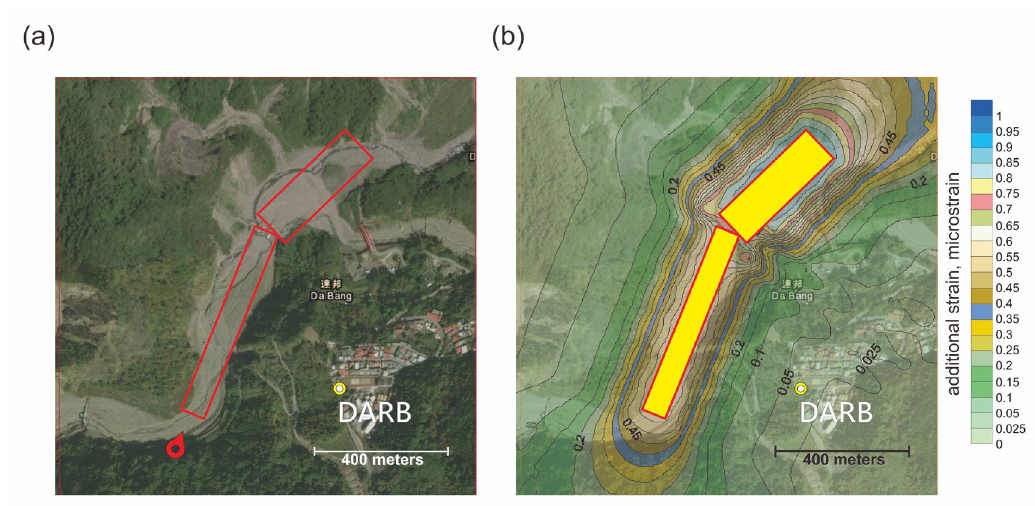
Figure 10. Effects of the river sediment on the areal strain observed at the DARB station. ( a ) The diagram shows contour of additional loading to the point where BSM was installed underground in DARB. Red blocks show the layout of assumed debris deposited area. ( b ) Additional strain induced by temporary earthflow (with given density of the earth flow 1200 kg/m 3 ) of 1 m thick in the river band taken as a strip load. The location where to take the picture is denoted as a red dot on the diagram.